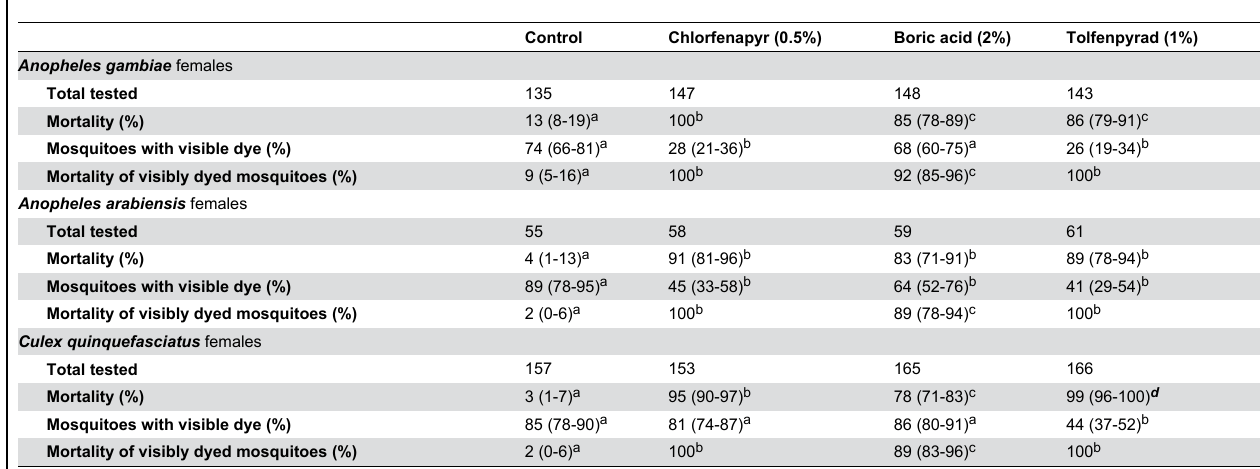
Table 1. Laboratory bioassays of three toxic sugar baits against An. gambiae s.s., An. arabiensis , and Cx. quinquefasciatus in cage tests. Numbers of female mosquitoes tested, the percentage dying, the percentage dyed with a red dye, and the percentage of dyed mosquitoes that died (and 95% confidence intervals) are